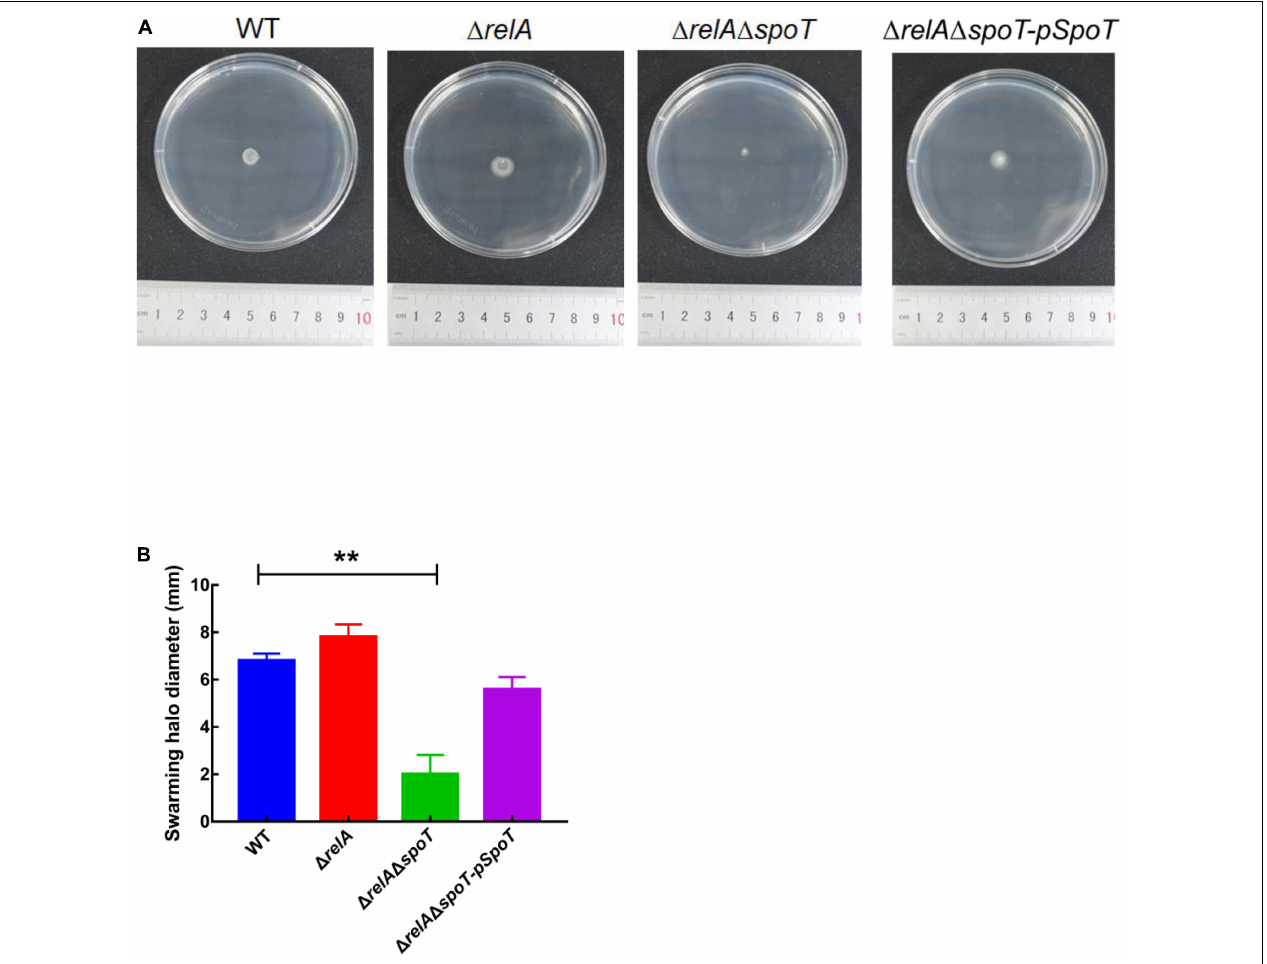
FIGURE 5 | The effects of relA and spoT on the swarming ability. (A,B) The diameter of swarming rings of WT, (cid:49) relA , (cid:49) relA (cid:49) spoT , and (cid:49) relA (cid:49) spoT-pSpoT was recorded after 12 h of continuous culture on 0.9% 2216E agar plates at room temperature. Results were presented as mean ± SD ( n = 3). ** indicates p ≤ 0.01. Three separate experiments were performed with biological triplicates each, and a representative image was